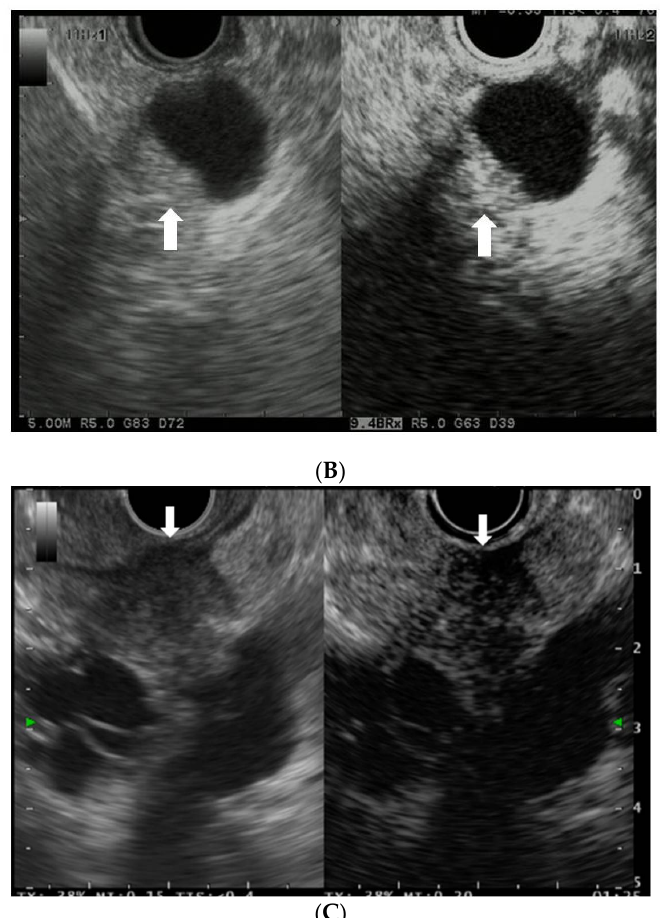
Figure 1. ( A ) Representative case of a mucus clot without vascularity. Conventional endoscopic ultrasonography (EUS; left) reveals an isoechoic mural lesion (arrow) in a cyst. Contrast-enhanced harmonic EUS (right) reveals a mural lesion (arrow) without vascularity. ( B ) Representative case of a mural nodule with vascularity. Conventional endoscopic ultrasonography (EUS; left) reveals an isoechoic mural lesion (arrow) in a cyst. Contrast-enhanced EUS (right) reveals a mural lesion (arrow) with vascularity. ( C ) Representative case of an invasive IPMC. Conventional endoscopic ultrasonography (EUS; left) reveals a hypoechoic lesion (arrow). Contrast-enhanced EUS (right) reveals a hypoenhancing lesion (arrow) due to early wash-out.